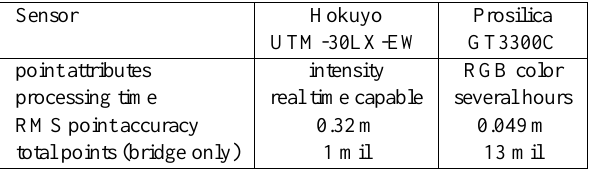
Table 1: Properties of LSRF and SfM point